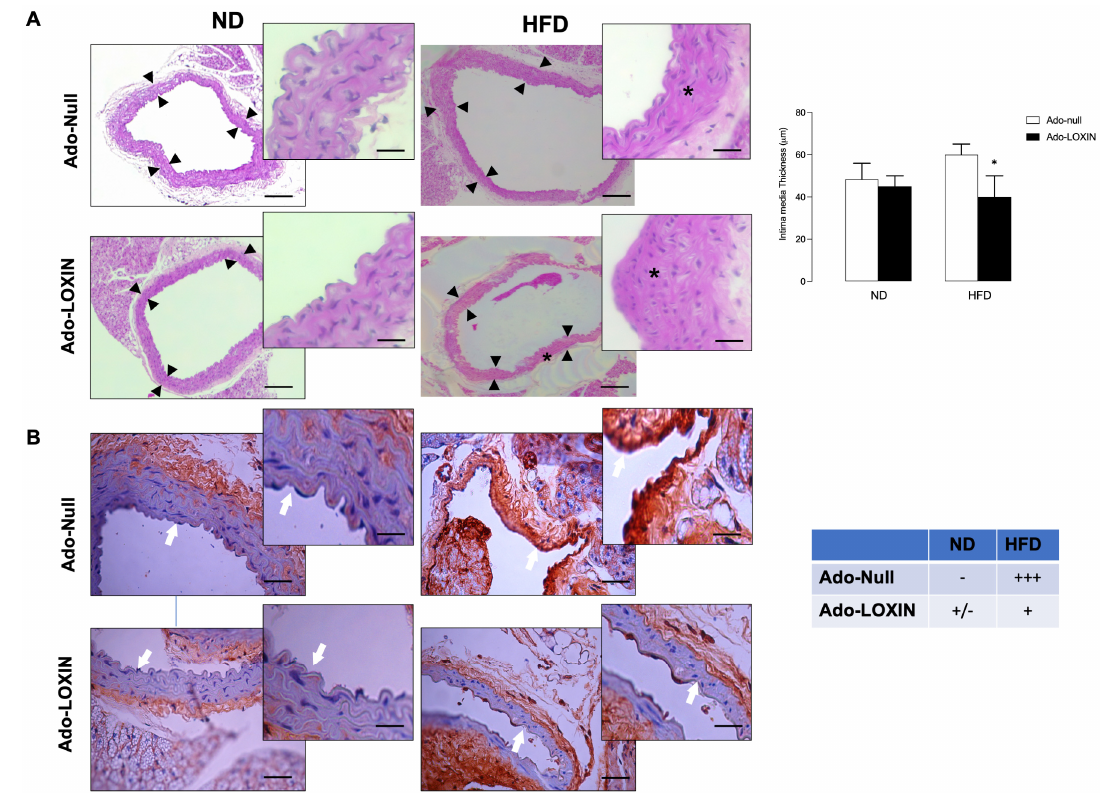
Figure 4. Effects of Ado-LOXIN on expression Lox-1 in mice fed a high-fat diet. ( A ) Representative microphotographs of hematoxylin-stained cross-sections of aortic plaques. * Represent perivascular alteration. Scale bars indicate 150 μ m. The figure on the right shows the quantification of the aorta thickness ( n = 5). ( B ) Immunohistochemical staining of antibody anti-Lox-1 was performed in permeabilized tissue sections obtained after Ado-LOXIN or empty vector injection, Ado-Null fed a normal diet (ND) or high-fat diet (HFD). Arrows indicated endothelial cells positive for Lox-1. Scale bars indicate 25 μ m. The figure on the right shows the quantification of Lox-1 in crosses ( n = 5). The high magnification imaging was performed in the area delimited in pictures A and B. Statistical significance is represented as * p < 0.05.